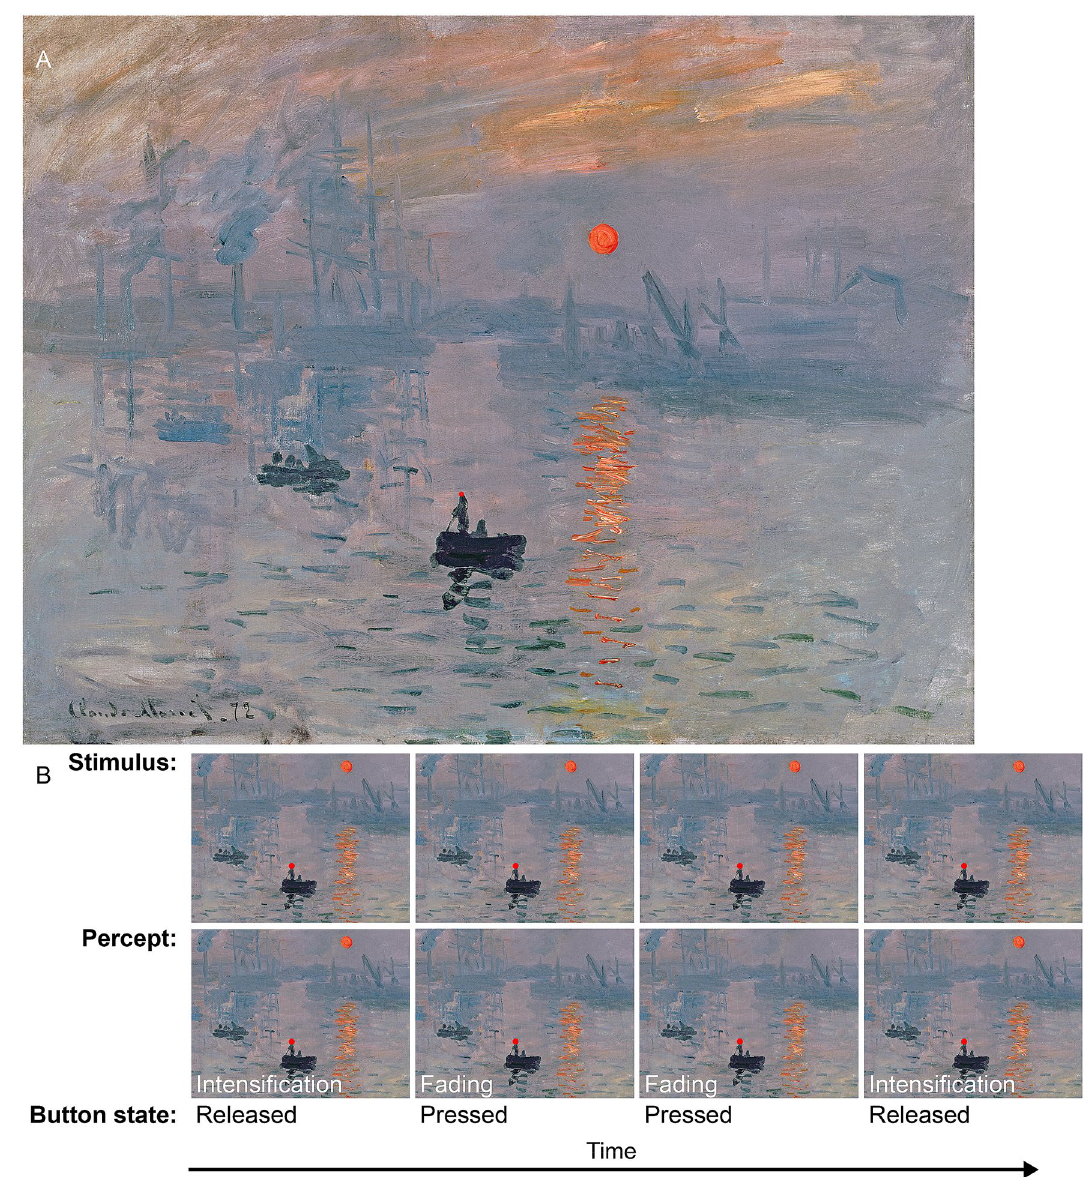
Figure 1. Experimental design. ( A ) Monet’s “Impression, soleil levant,” presented at its original orientation, with the addition of a red spot on the hat of the person standing in the boat. This red spot served as a fixation target during the experiment. To experience the perceptual fading of the sun, look at the red spot and hold your gaze still for about a minute while covertly focusing your attention on the sun. ( B ) Epochs from a Monet trial. The physical stimulus is shown in the top row, the participant’s perception of the stimulus in the second row, and the participant’s report in the third row. The perceptual experience is consistent with Troxler fading 1 : the sun disappears perceptually, and fills-in with the colour of the surrounding background. The fixation spot is not to scale. Reproduction from Musee Marmottan Monet, Paris, France/Bridgeman